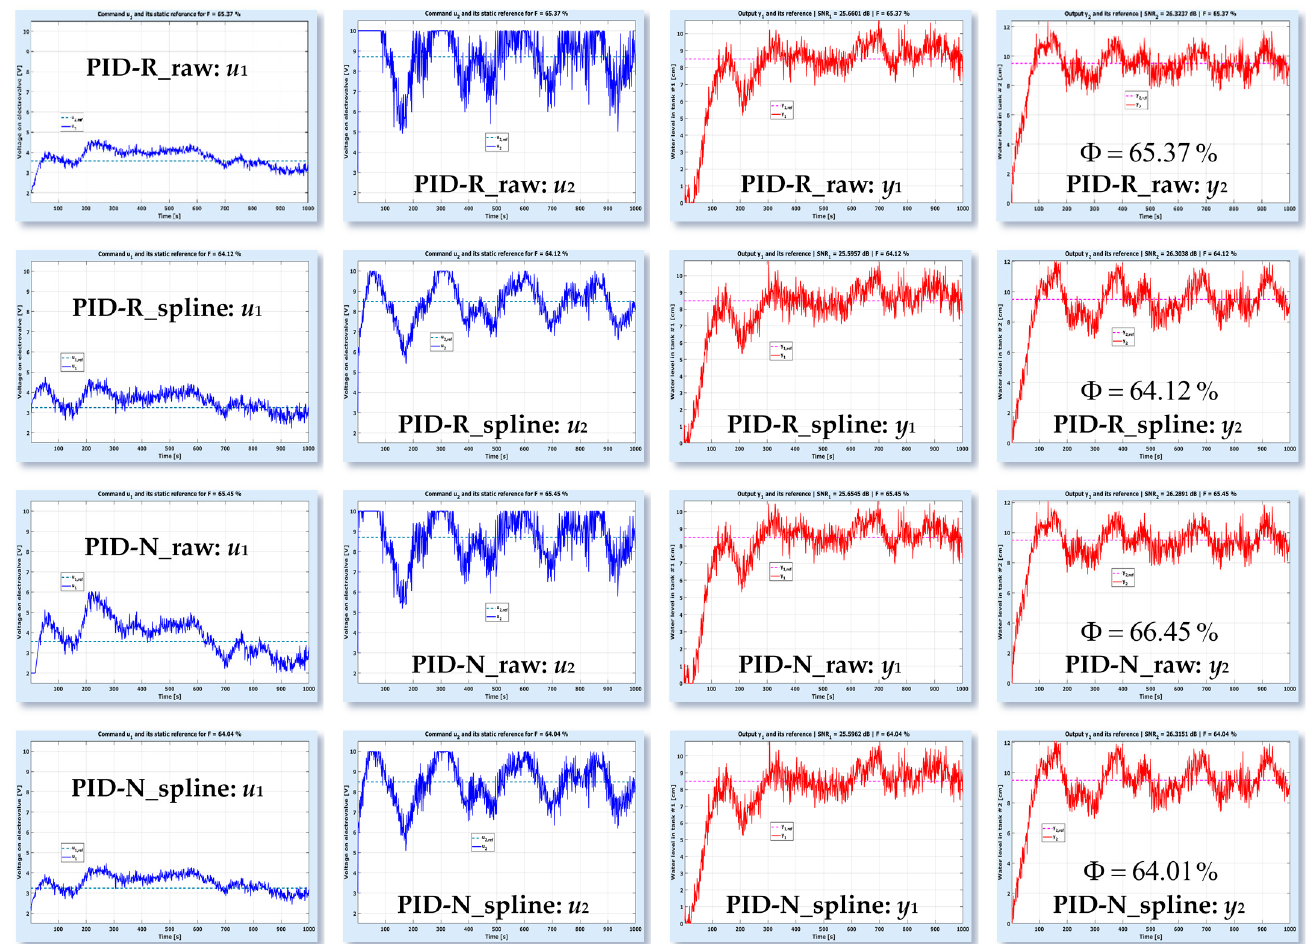
Figure 25. PID-ASTANK2 performance at the margin of robustness against exogenous noises.